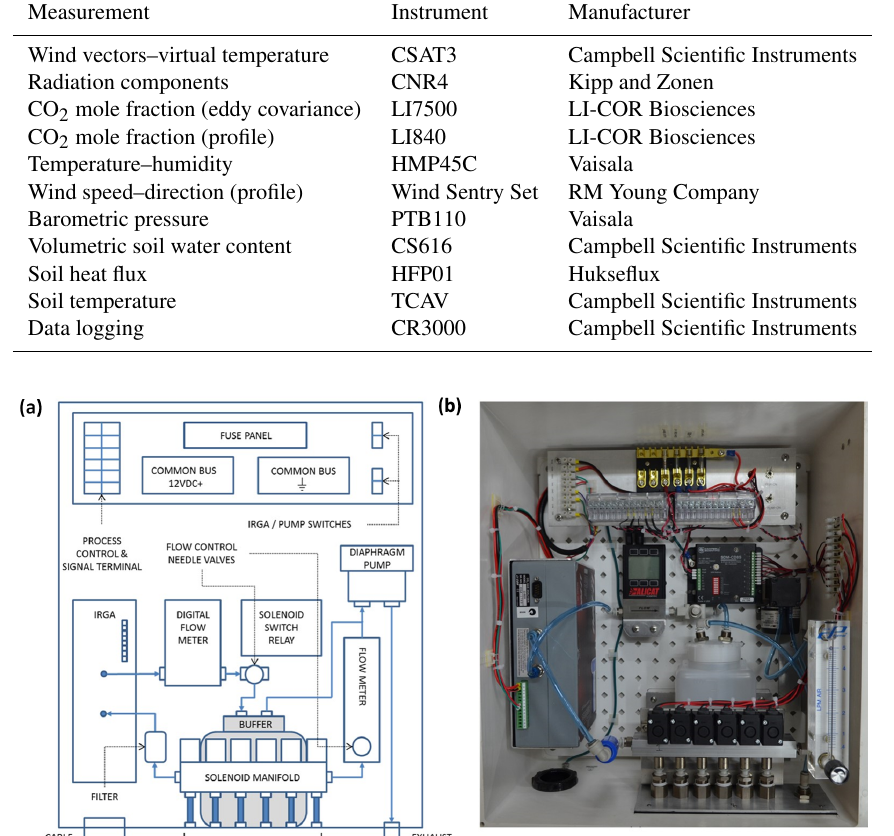
Table 2. Site instrumentation.